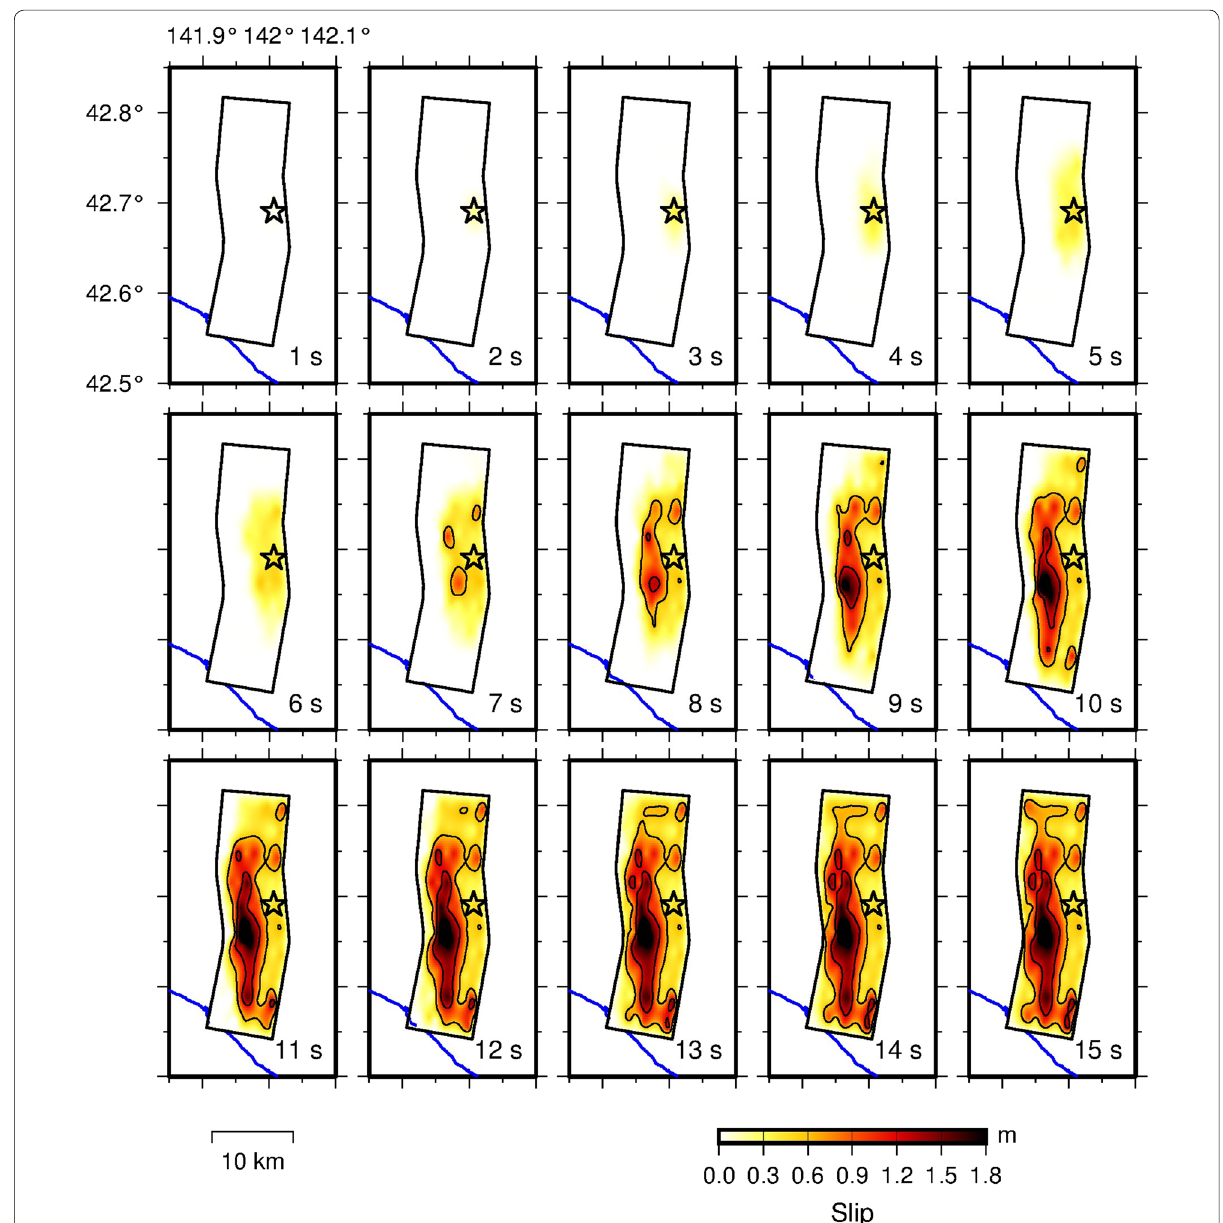
Fig. 7 Snapshots of the temporal slip progression projected on map at every 1